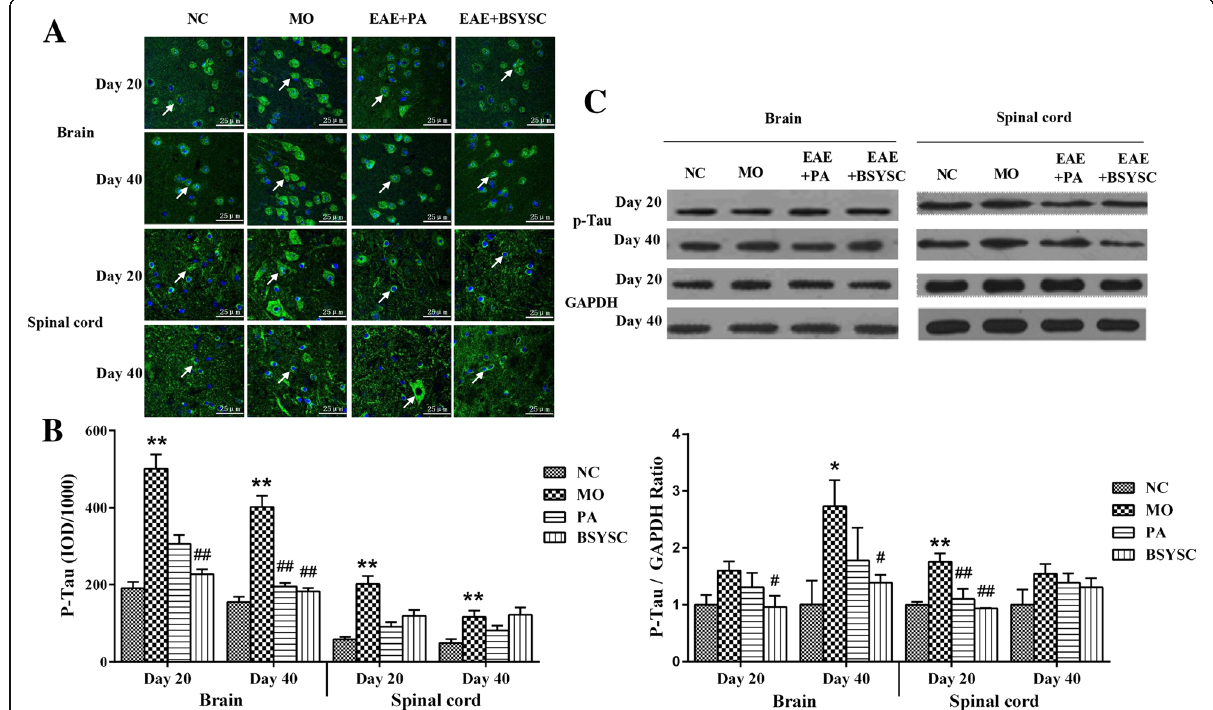
Fig. 2 P-Tau protein expression in the brain and spinal cord of mice treated with or without BSYSC 20 and 40 dpi. The protein levels of p-Tau were reduced to different degrees in BSYSC group. a The representative immunofluorescent staining of p-Tau was shown in each group, the white arrows indicate the positive regions, magnification (×40). b Semi-quantification of integrated optical density (IOD) on p-Tau expression was exhibited. c The protein level of P-Tau was measured by Western blot and quantified using GAPDH as the loading controls. Data are expressed as means ± SE, n = 5 for each group. * p < 0.05, ** p < 0.01 vs. NC; # p < 0.05, ## p < 0.01 vs.